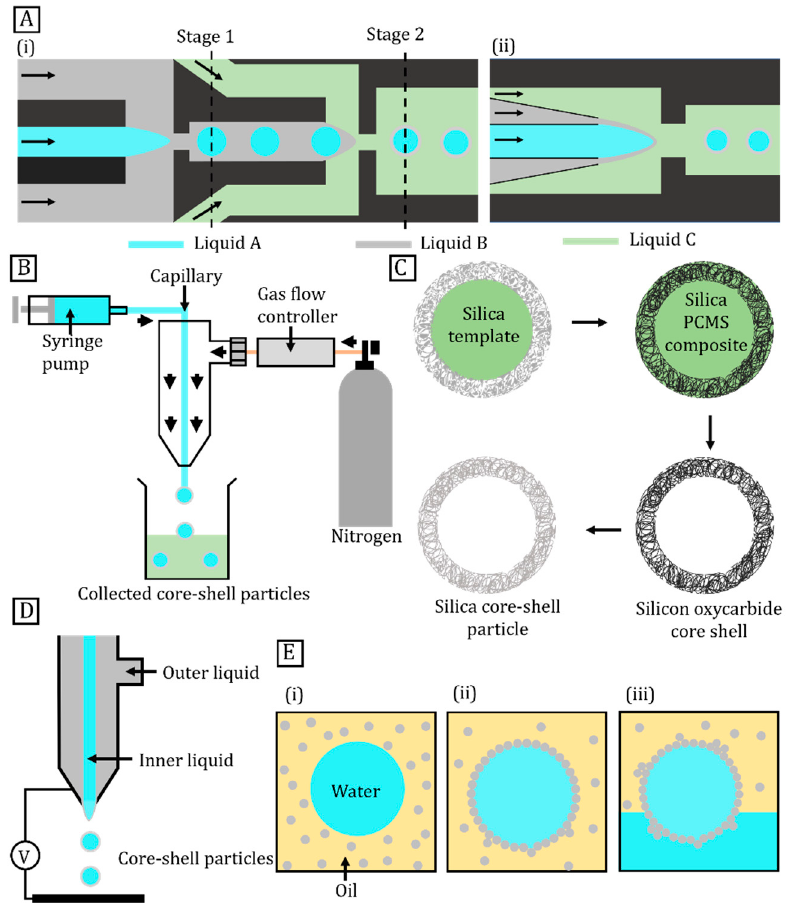
Figure 3. Fabrication techniques for core–shell particles. ( A ) Core–shell particle fabrication using ( i ) a two-step microfluidic method and ( ii ) a one-step method; ( B ) Experimental setup of gas-shearing method for core–shell particles; ( C ) Sol–gel method for silica core–shell particles; ( D ) Electrospray method; ( E ) Core–shell particles formation by self-assembly: ( i ) Oil-suspended water droplets and particles. ( ii ) Particles adsorb at oil–water interface to form core–shell particle. ( iii ) Transferring formed core–shell particles to water by